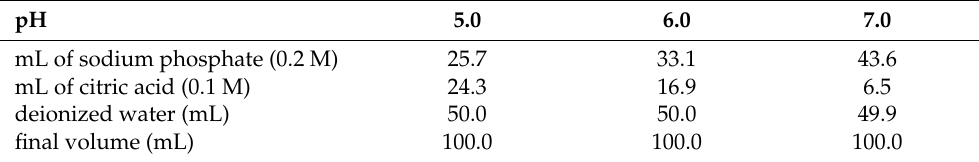
Table 1. Final volumes needed to achieve the acidic